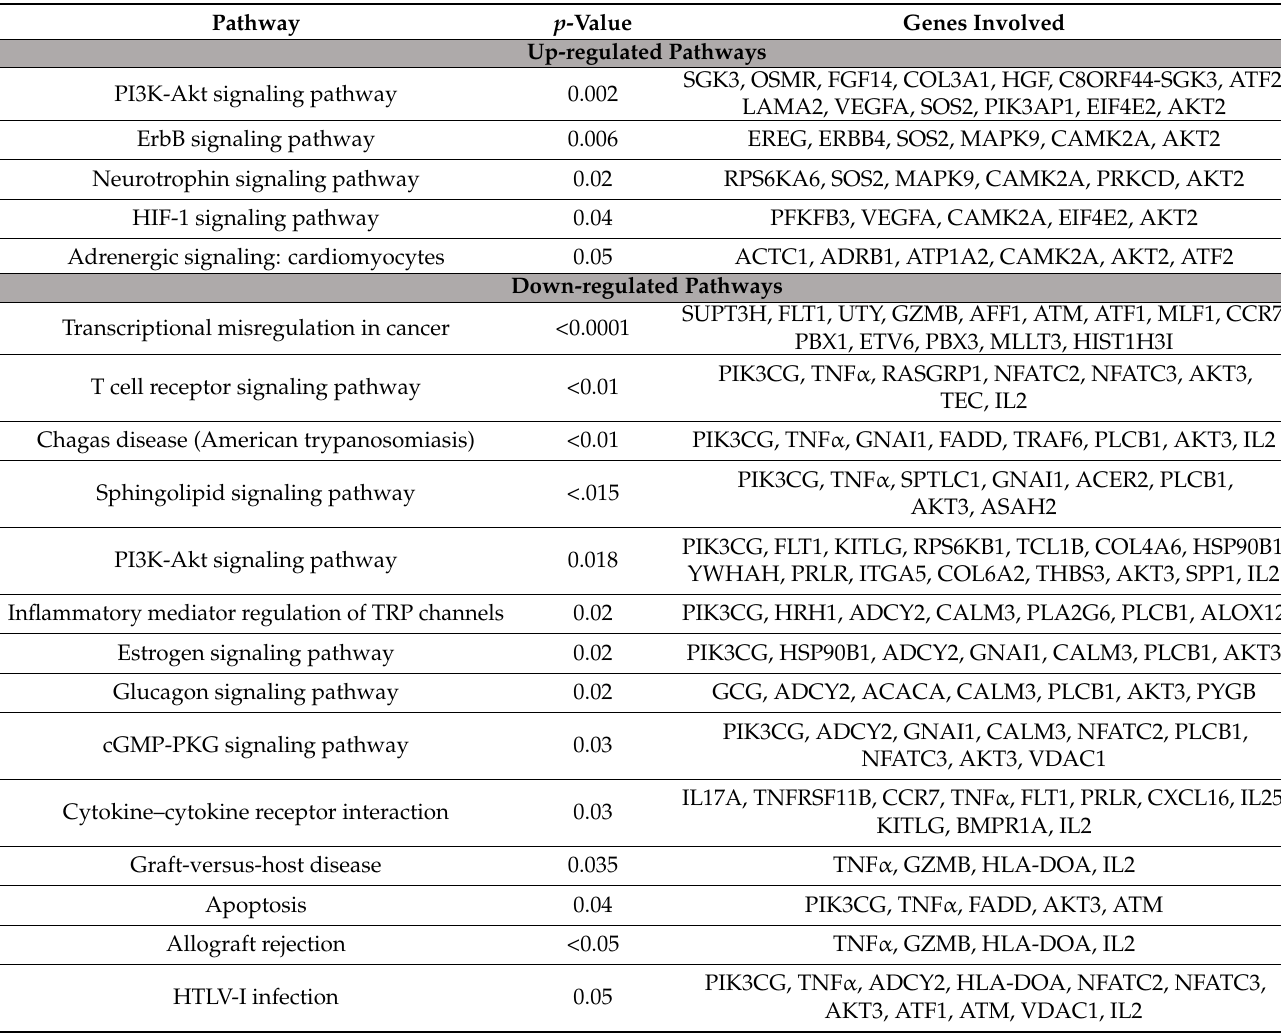
Figure 5. Gene expression of ( A ) AKT serine/threonine kinase 3 (AKT3), ( B ) AKT serine/threonine kinase 2 (AKT2), and ( C ) tumor necrosis factor α (TNF) in ASD, controls, and siblings. CNT = controls, ASD = autism spectrum disorder, and SIB = siblings. Data are means ± SEM of n = 9–10 samples in each category. Error bars represent standard error of the mean. Gene expression was normalized to GAPDH for each group. * p ≤ 0.05. Table 3. Significantly enriched KEGG pathways in differentially expressed miRNAs in the dataset.